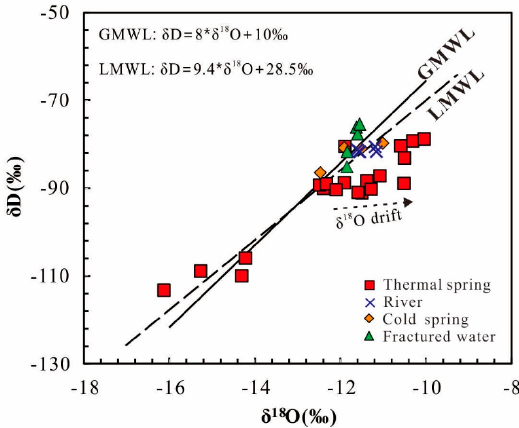
Figure 12. Variation of δ D and δ 18 O in groundwater and thermal springs associated with Global Meteoric Water Line (GMWL) [36] and Local Meteoric Water Line (LMWL) [37].